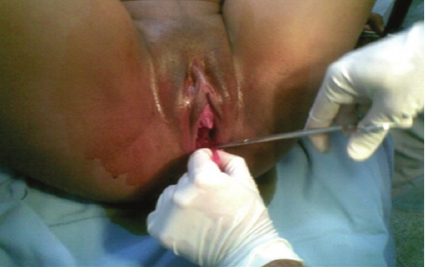
Figure 3: Intrapartum resection of the septum performed using